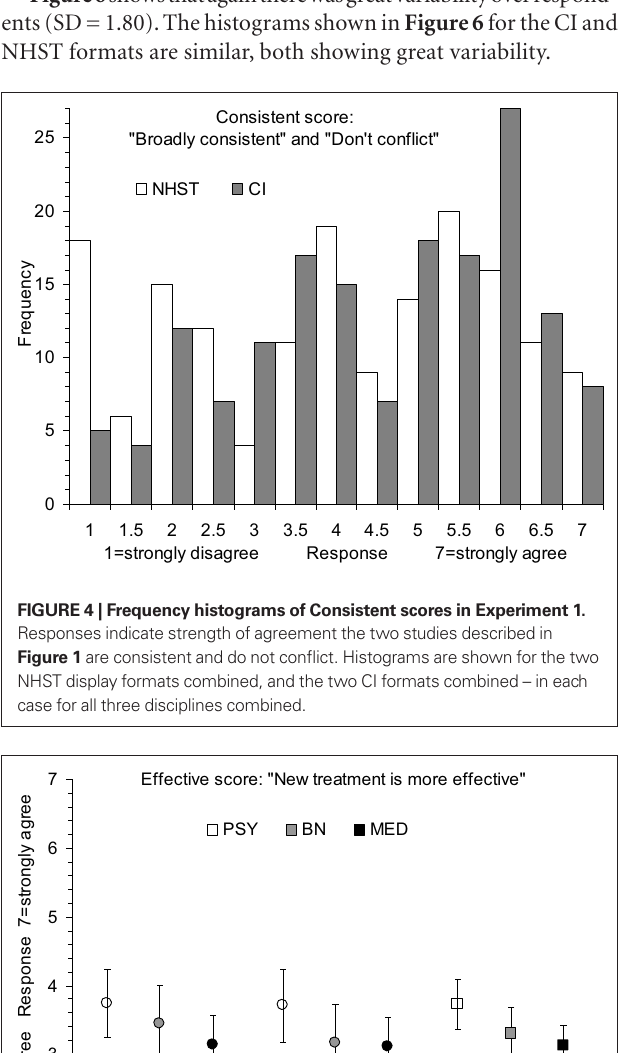
Figure 5 | Means and 95% Cis of the effective score in experiment 1, for six independent groups of respondents combining figure and text formats, and for the three disciplines – psychology (PSY), behavioral neuroscience (BN), and medicine (MeD) – combining all formats. Responses indicate strength of agreement there is evidence the new treatment is more effective. Sample sizes are as shown in Figure 3 .